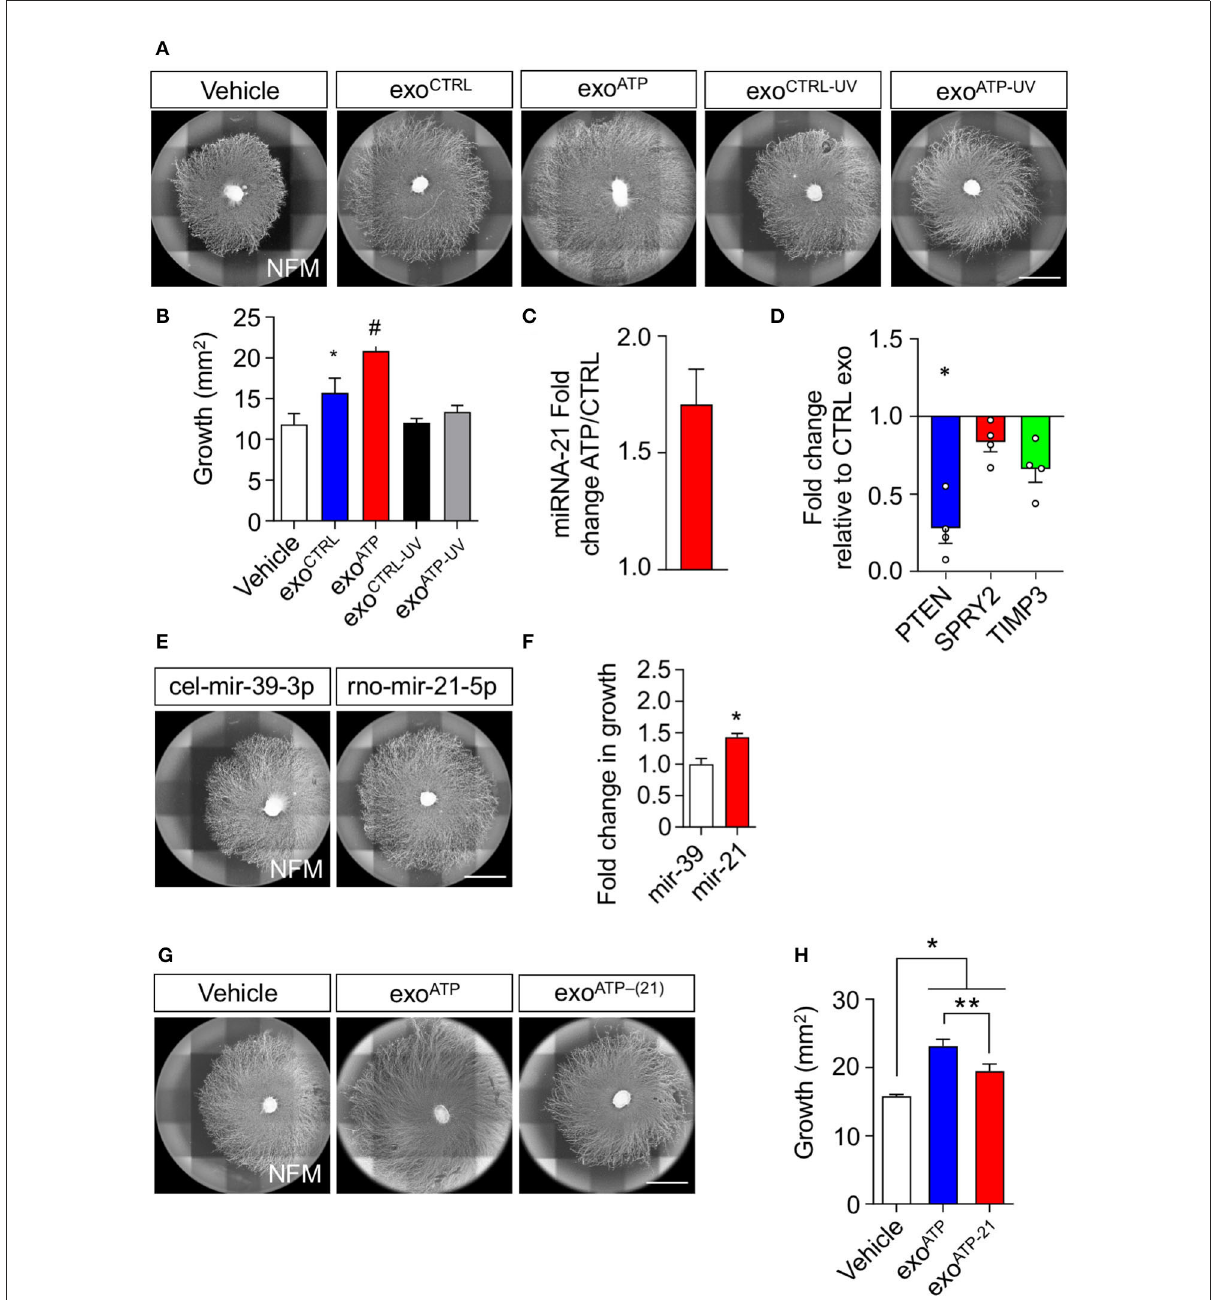
FIGURE4 miRNA-21 is a key participant in the axonal elongation effect of rSC-derived sEV on DRG neurons. (A,B) RNA participation in the axonal elongation effect of sEV over DRG neurons was first evaluated by UV irradiation. Axonal growth was analyzed on day 4 after adding rSC-derived sEV daily from SC treated with or without ATP to the DRG neurons. For RNA inactivation, EVs were previously UV irradiated. The axonal elongation of DRG induced by sEV was visualized by immunofluorescence using neurofilament medium (NFM) immunostaining in axons. Scale bar, 1,500 µ m. (C) miRNA-21 content in rSC-derived sEVs was assessed by qPCR in sEV samples from control or ATP-stimulated rSCs. (D) Expression of PTEN, SPRY2, and TIMP3 was measured by qPCR from DRG neurons after treatment with sEV derived from control or ATP-treated rSC. (E,F) The involvement of miRNA-21 was assessed by transfection of miRNA-21 inhibitors or mimics in rSC. miRNA-21 was directly transfected in DRG neurons, and the axonal growth area was analyzed 4 days after transfection, and the miRNA mimic mir-39-3p with no known rat mRNA target was used as a control. The increased axonal growth induced by transfection of miRNA-21 was visualized by immunofluorescence using neurofilament medium (NFM) immunostaining in axons. Scale bar, 1,500 µ m. (G,H) SCs were transfected with miRNA-21 inhibitors, sEVs were purified, DRG were treated daily with these sEVs, and the axonal growth area was analyzed 4 days after transfection. The effect of the inhibitors on the sEVs and their axonal elongation effect were visualized by immunofluorescence